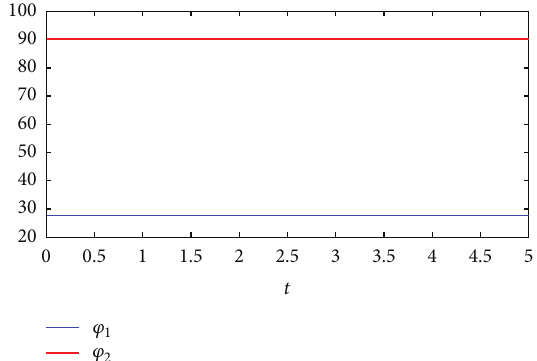
Figure 1: The energy evolution according to 𝑡